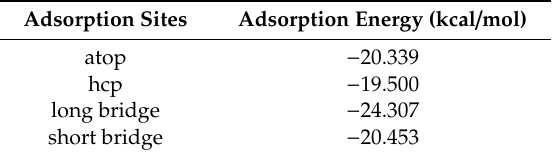
Table 2. Adsorption energies of each adsorption site.